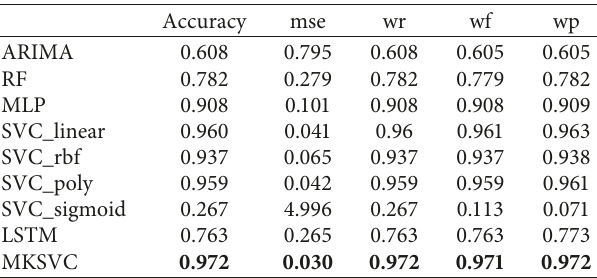
Table 7: Performance comparison for predicting the next hour’s AQHI in HK.